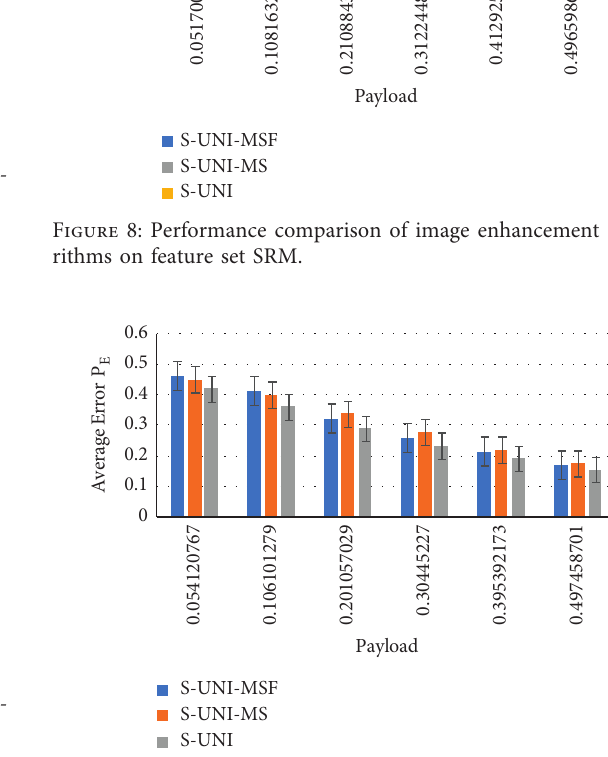
Figure 9: Performance comparison of image enhancement algo- rithms on feature set max SRM.